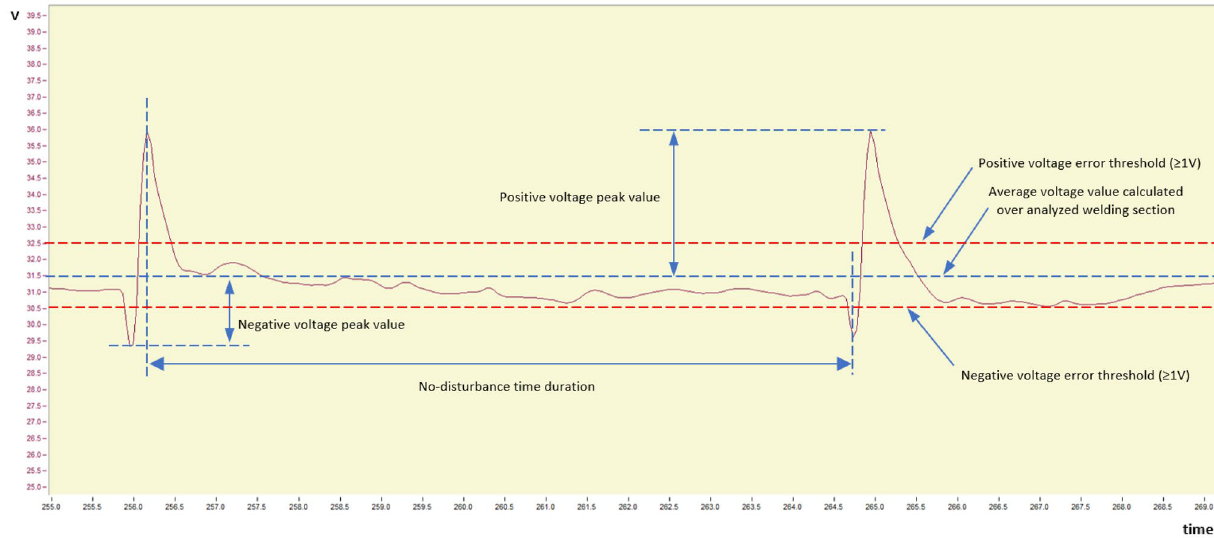
Fig. 12 Method of analyzing voltage disturbances responding to explosions in the spray